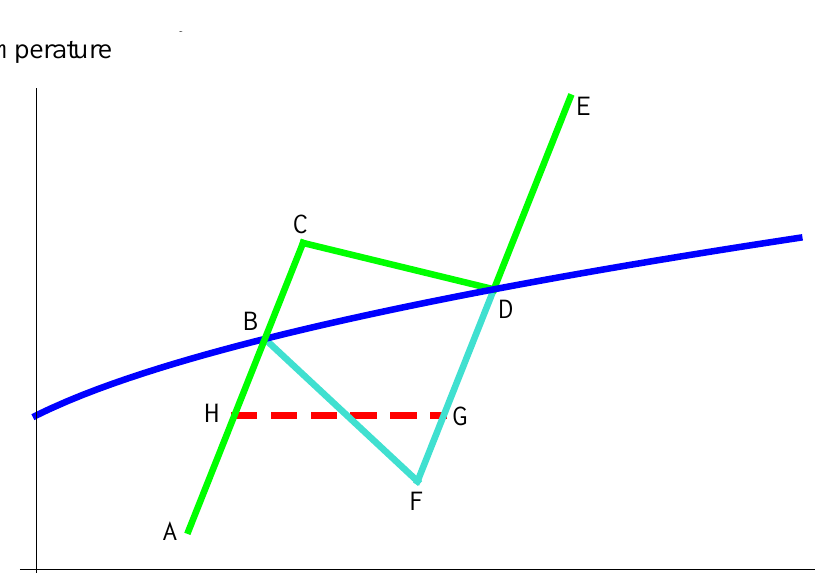
Figure 1. Typical isochore used in the Z methodology. Different segments of the isochore correspond to solid (AB), superheated solid (BC), liquid (DE), and supercooled liquid (DF) states. Melting corresponds to segment CD. Isochoric and isothermal solidification processes correspond to segments FB and GH, respectively, and are used in the so-called inverse Z method [2].